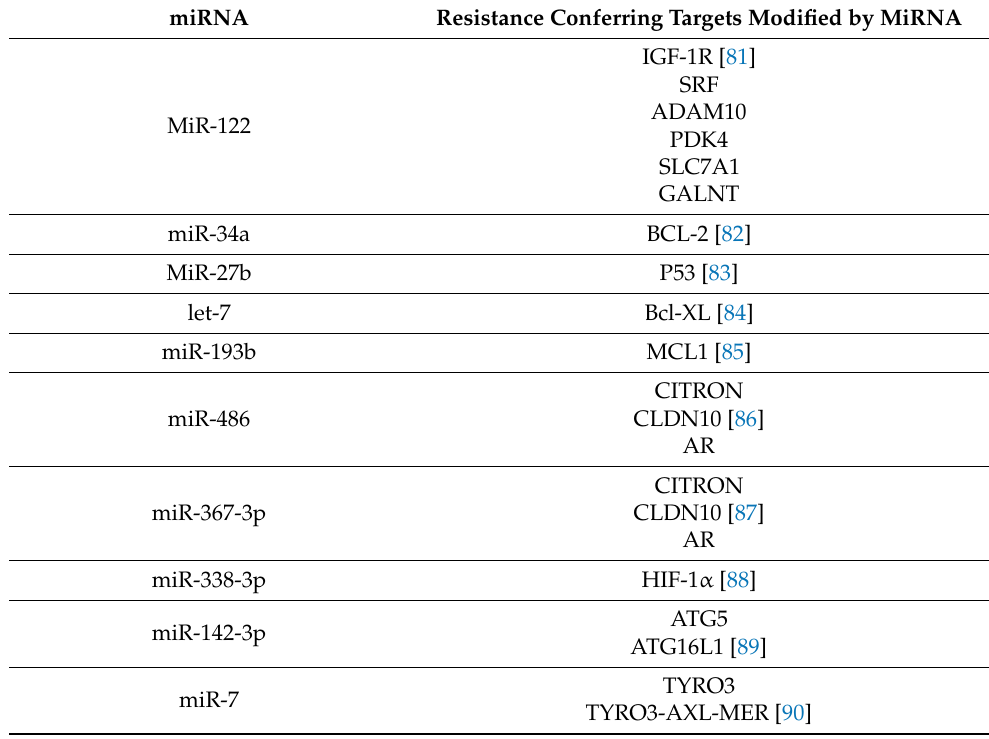
Table 5. Micro RNA mediated regulation of drug